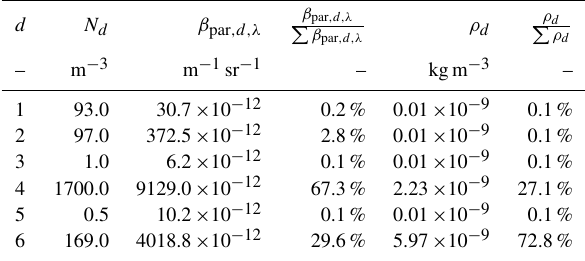
Table 5. The same as Table 4 but for coordinate 2 on 16 April 2010, 09:00UTC, at a height of 1.5kma.s.l. Even if class 4 carries only 27% of the mass, it contributes 67% of the total backscatter co- efficient. The inverse situation can be observed for the size class 6, which holds 73% of the mass but contributes only 30% of the backscatter coefficient at this